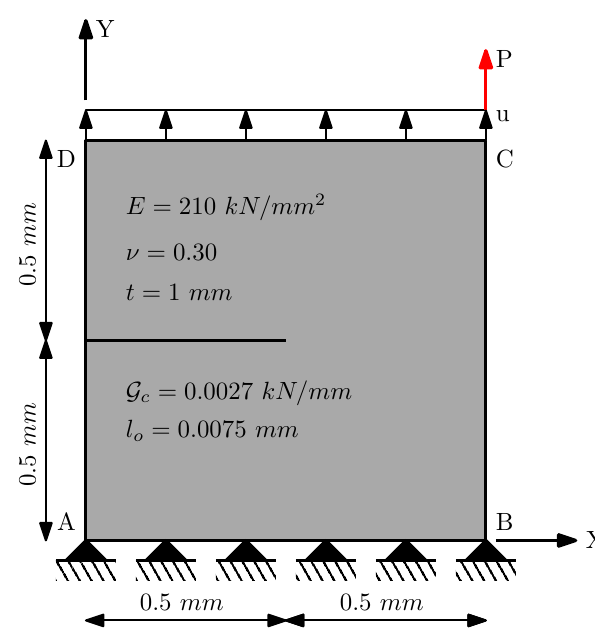
Figure 11. Tension test geometry, material parameters, loading and boundary